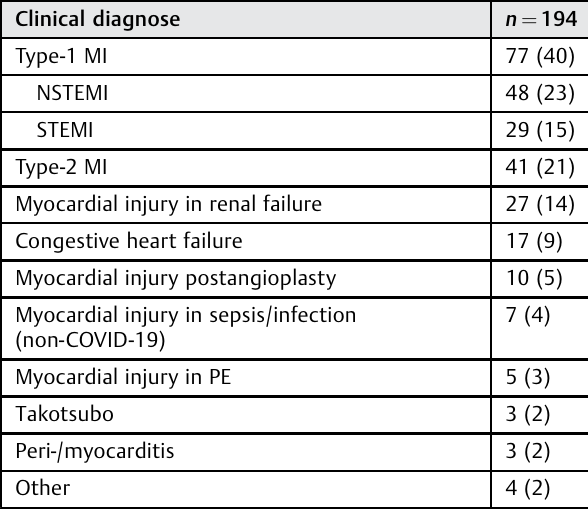
Abbreviations: COVID-19, novel coronavirus disease 2019; MI, myo- cardial infarction; NSTEMI, non-ST elevation MI; PE, pulmonary embo- lism; STEMI, ST elevation MI. Note:Continuousvariablesareexpressedasmean (cid:3) standarddeviation, median [interquartile range] or n